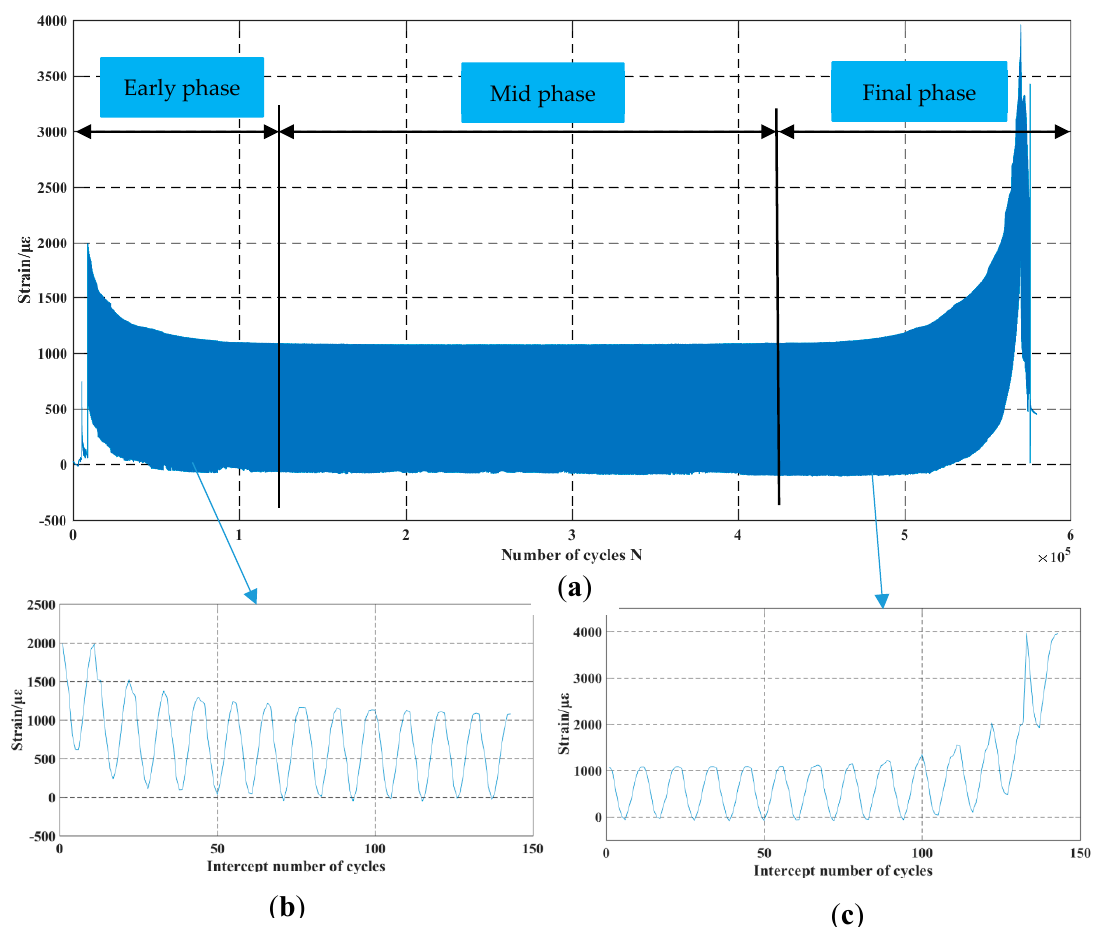
Figure 11. Strain time history curve (testing point 3#): ( a ) Overall process; ( b ) Early phase (“strain decline” Phase); ( c ) Final phase (“strain rise” phase).